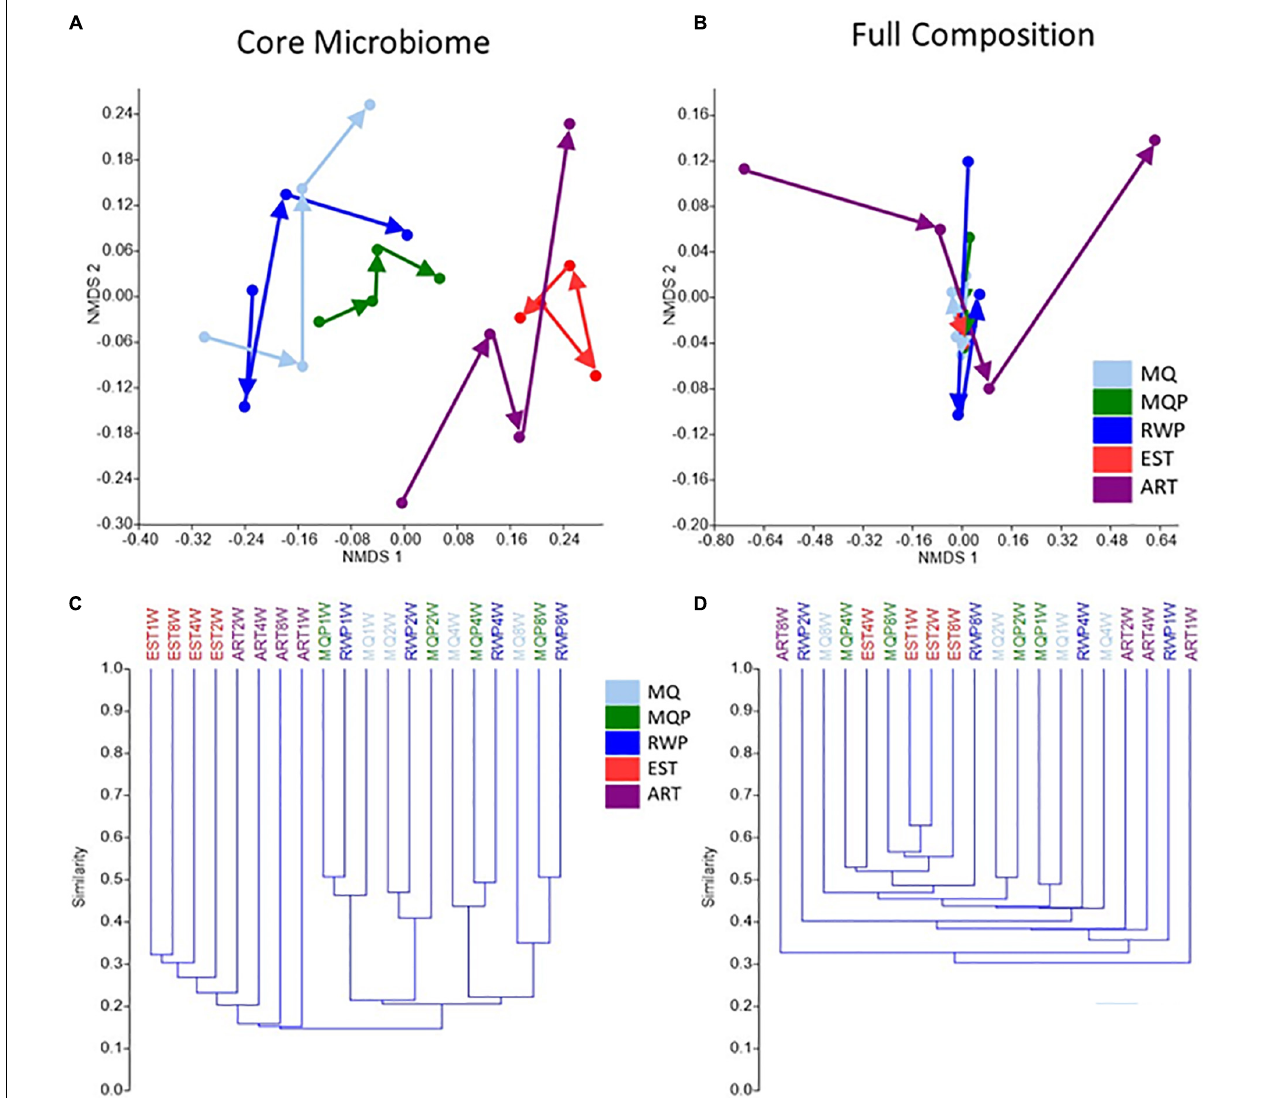
FIGURE 5 | Pitcher bacterial composition for each of the five treatments, over time visualized with NMDS (A,B) and UPMGA trees (C,D) using Jaccard similarity index, comparing core microbiome (A,C) with full bacterial composition (B,D) . Each datapoint represents the pooled OTUs identified in 7 pitchers per treatment shows a timepoint (1, 2, 4, 8 weeks) and arrows indicate successional trajectories for the 5 treatments. Core microbiome was the bacterial OTUs present in at least 85% of all 7 replicate pitchers within each treatment. Treatment abbreviations are the same as Figure 1